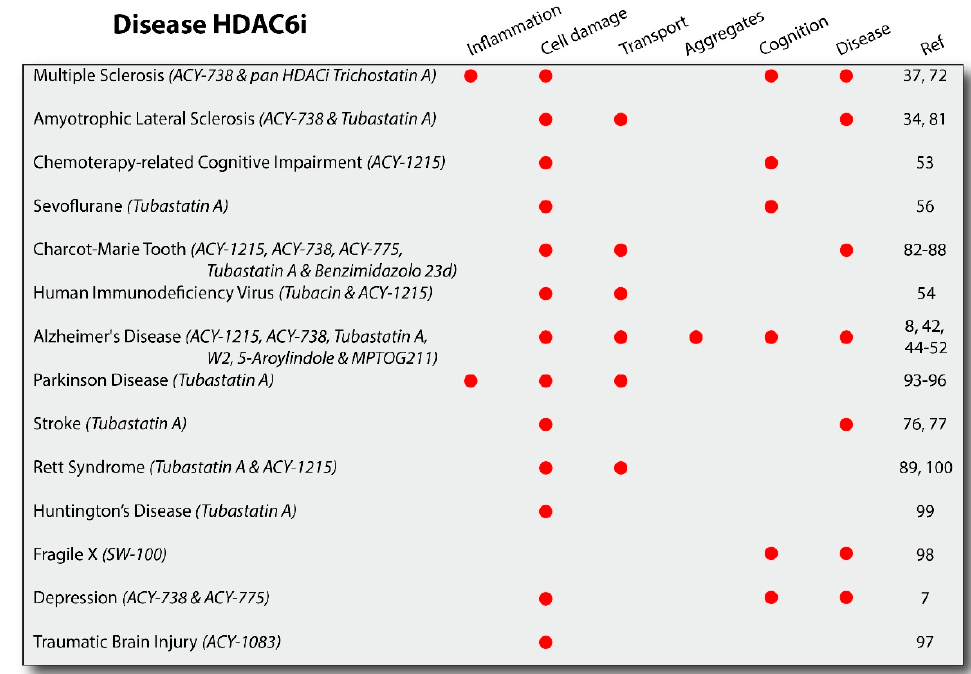
Figure 3. HDAC6 inhibitors in neurodegenerative diseases. HDAC6 inhibitors (HDAC6i) have been studied in several diseases (e.g., degenerative, developmental, and following toxins/infection) and have been shown to improve a combination of pathologies including inflammation, cell damage, transport regulation, aggregation, cognition, and disease course. The results shown in this figure reflect studies done with the drugs as indicated. As additional HDAC6i are developed and more studies are performed, additional results could add insight into the overall benefits of this class of drugs. All the drugs indicated are HDAC6i with the exception of Trichostatin A, an inhibitor for class I and II HDAC isoforms.